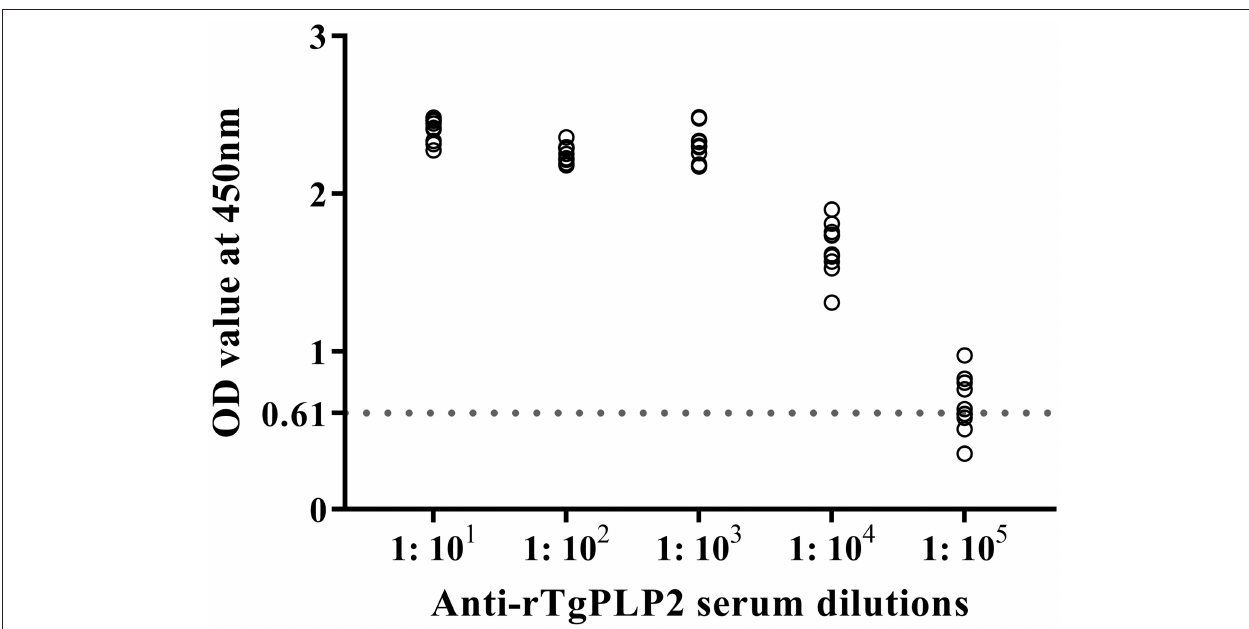
FIGURE 4 | Serum titers of anti-rTgPLP2 IgG antibody measured by rTgPLP2-ELISA. Sera from 10 mice immunized with rTgPLP2 were taken for ELISA, and normal mice serum was used as negative control. The cut-off values (0.61) are shown with a dotted line.